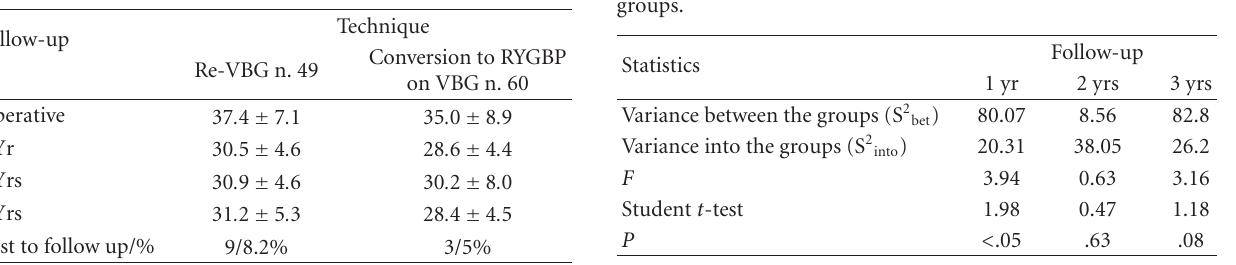
Table 5: Outcomes of revisionary surgery for failed or complicated VBGs: changes in BMI.